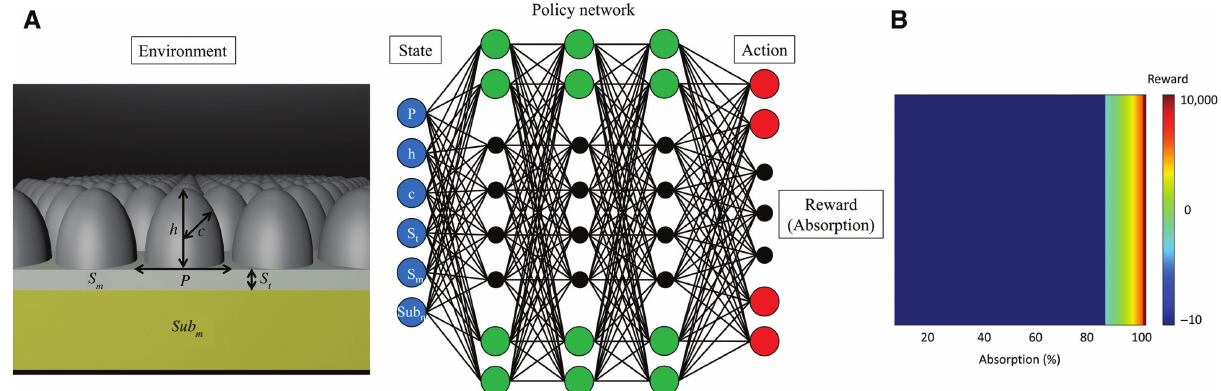
Figure 10: Reinforcement learning applied to designing ultra-broadband absorbers for a variety of transition metals. (A) A schematic of the moth-eye perfect absorber design and the policy network for the DDQN. (B) A visual representation of the shaped reward system. Figures are reprinted from Ref. [98] with permission (CC BY